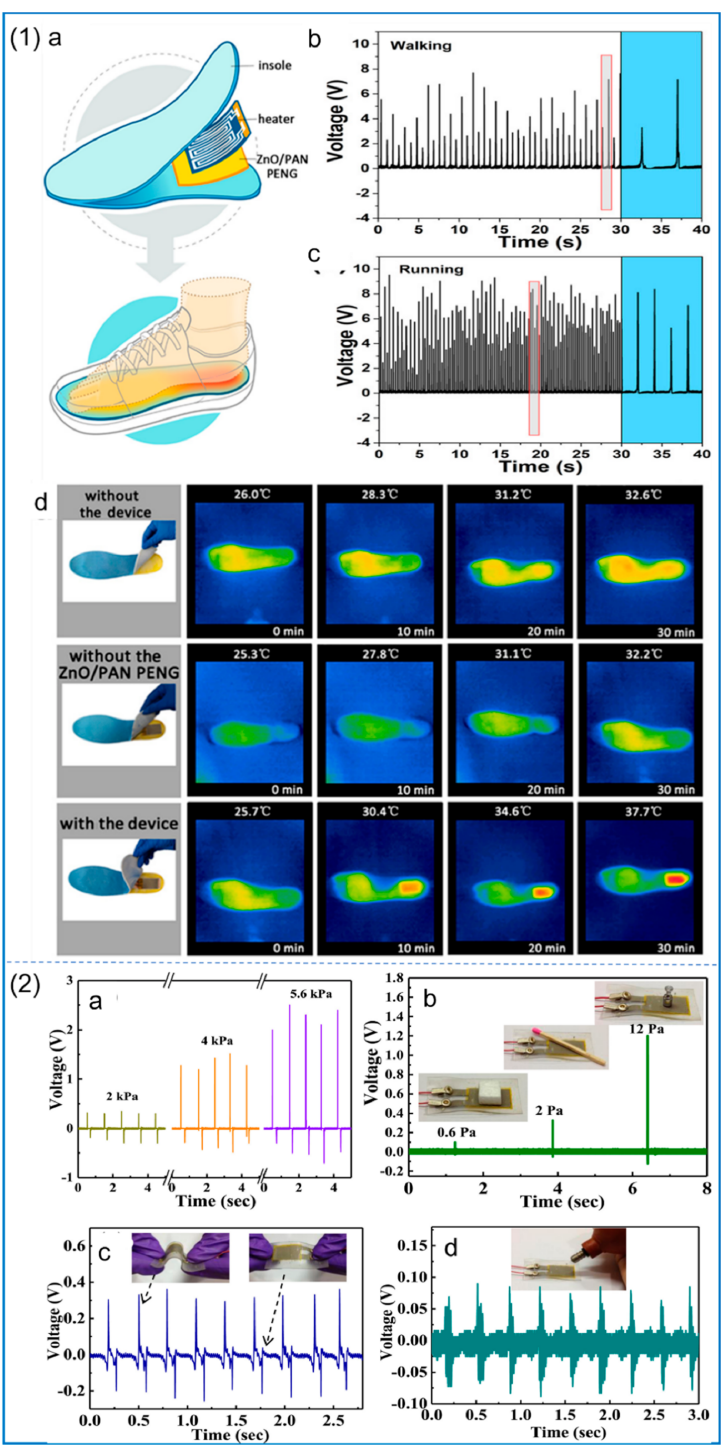
Figure 16. ( 1 ) The electric energy made by PNG is used to drive the electric heating plate. ( a ) Schematic diagram of self-heating insole. Digital photo and infrared image of the output voltage generated by PNG during ( b ) walking and ( c ) running, the blue inset is a partial enlargement of the red box, ( d ) insole. Reprinted with permission from Ref. [146], copyright 2020, American Chemical Society. ( 2 ) ( a ) Plot of voltage response as a function of time for different applied pressures under finger impingement. ( b ) Output voltage response of PNG with polystyrene, matchstick, and weight placed at the top. Piezo − response plots for loading and unloading cycles under ( c ) bending and ( d ) blower pressure. Reprinted with permission from Ref. [203], copyright 2018,